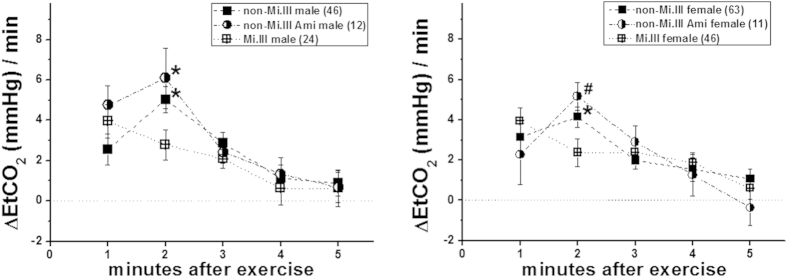
Expedited CO2 expiration following the step test was unique to Mi.III, and not to Miltenberger-negative Ami peopleThe data for Mi.III+subjects are shown in cross symbols; for non-Mi.III subjects, in solid symbols; and for Miltenberger-negative Ami people, in half-solid symbols. Shown mean ± SEM. *p < 0.05. #p < 0.01.